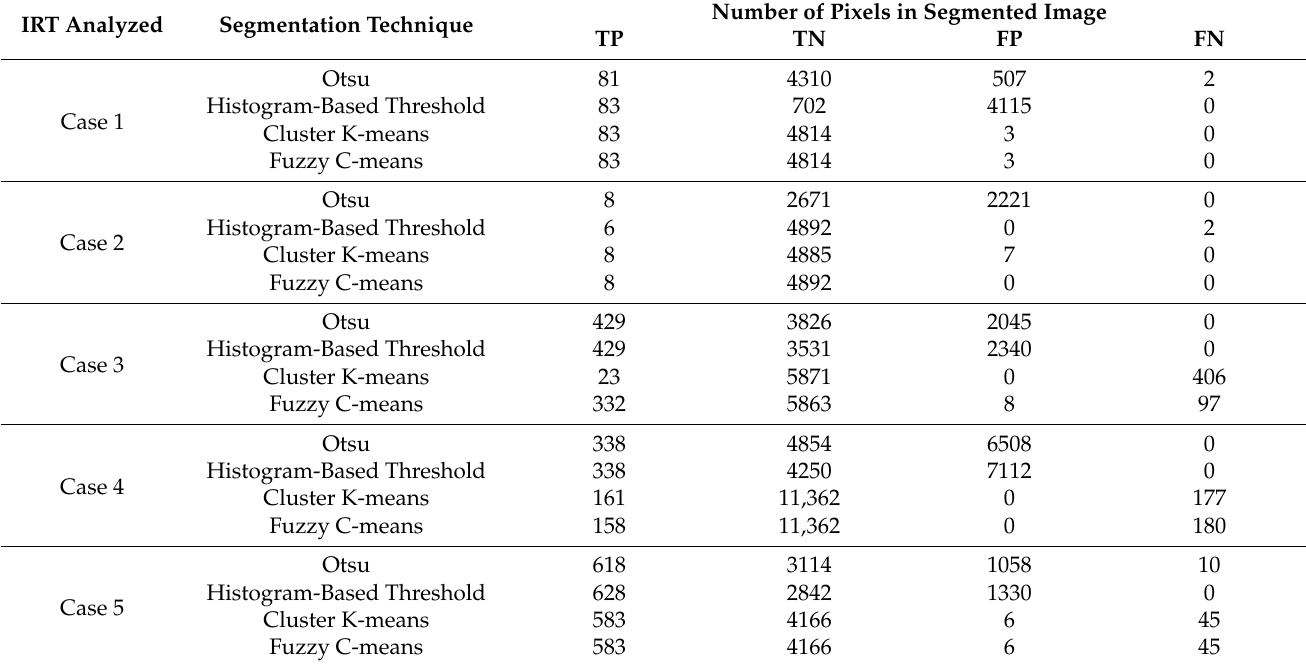
Table 3. Binary pixel classification of the segmented ROIs of the analyzed cases, where TP is true- positive pixels, FP is false-positive pixels, TN is true-negative pixels, and FN is false-negative